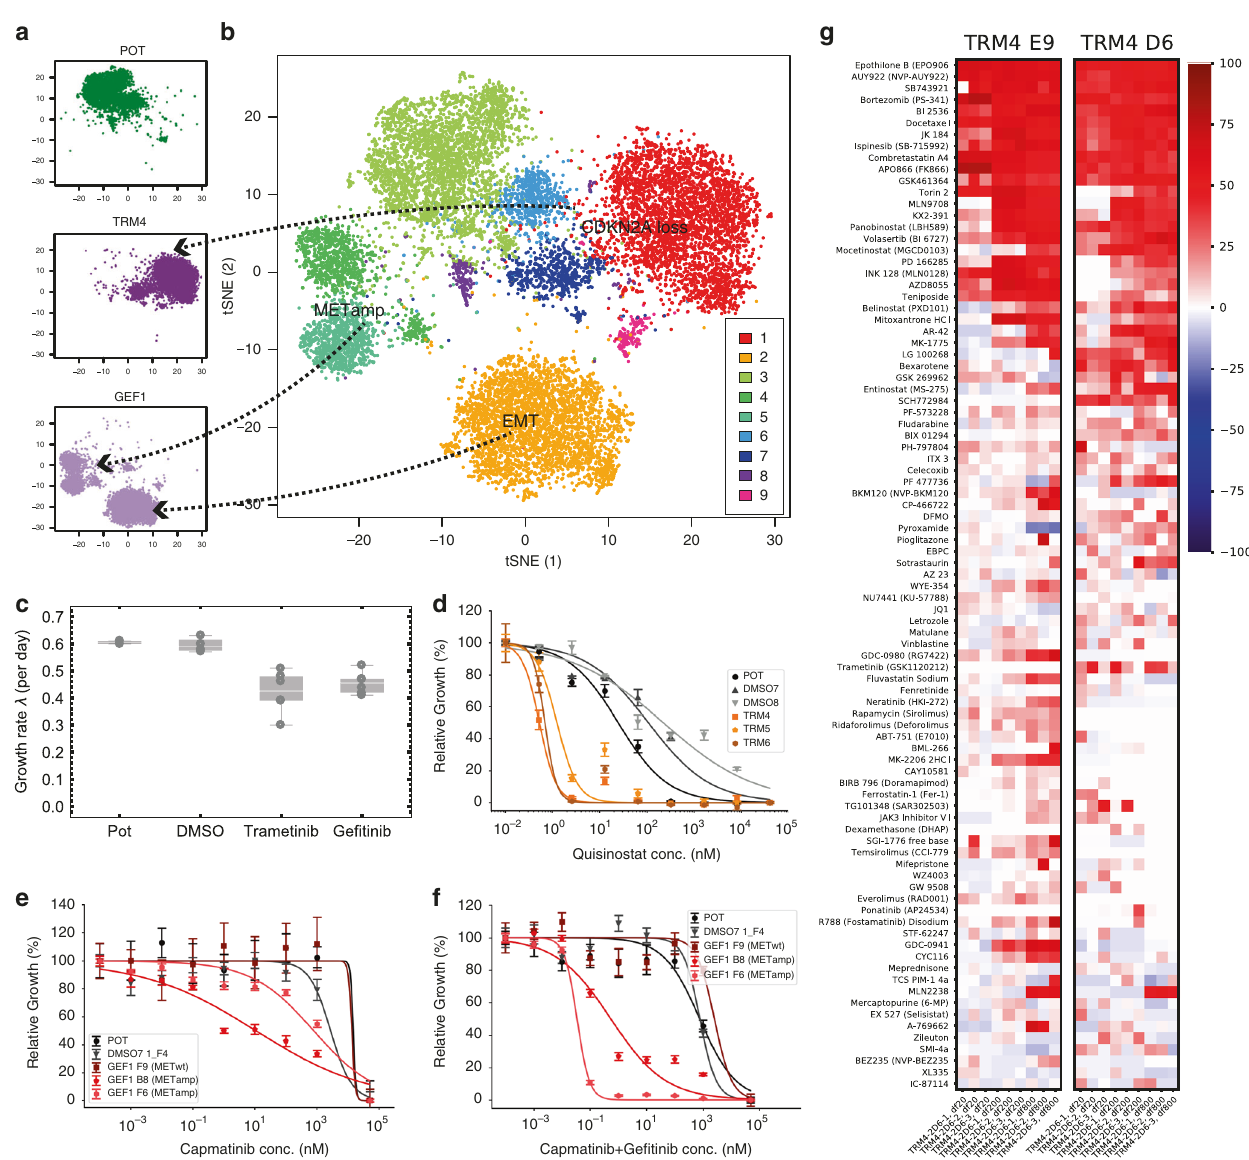
Fig. 5 Evolutionary steering leads to collateral drug sensitivity. a tSNE plot of single cell RNA sequencing coloured by sample (POT, TRM4 and GEF1 from top). b tSNE analysis of all samples together identi fi es 9 clusters with distinct transcriptomic pro fi les. c Growth rates of all lines in the absence of drugs show a cost of resistance in terms of proliferation in the evolve lines. Box plots show mean, interquartile values and the range. d Dose response curves of second generation HDAC inhibitor quisinostat show collateral drug sensitivity in TRM lines. e Dose response curve of single clones derived from ge fi tinib- resistant lines under MET inhibitor capmatinib show collateral sensitivity for clones that bear MET ampli fi cation (only B8 and F6). f Combination of capmatinib + ge fi tinib further increases collateral sensitivity of MET -ampli fi ed clones, in particular F6. g High throughput drug screening of 485 compounds shows collateral sensitivity in TRM clones TRM4 E9 (1 copy left of CDKN2A ) and TRM4 D6 (two copies left of CDKN2A ). Here we show top 5% with highest % change inhibition with respect to DMSO7 F4 (three copies of CDKN2A as HCC827 is a triploid line). Error bars of dose – response curves represent (Fig. 5a). Gene expression patterns con fi rmed that the ge fi tinib- population was mostly composed of a single CDKN2A loss sub- resistant population (GEF1) was composed largely of two major clone (Fig. 5b, cluster 1) and again CDKN2A loss was detectable subclones, one that was MET ampli fi ed (Fig. 5b, clusters 4 and 5) in a subpopulation of cells from the POT (cluster 6 — see Sup- and one that was EPCAM − /VIM + , indicative of epithelial to plementary Figs. 12 and 13). Hence, the scRNA-seq data con fi rms mesenchymal transition 45 or EMT (cluster 2). Indeed, EMT has the clonal composition reported by the barcodes. No over- been implicated in ge fi tinib resistance in lung cancer 35 . In expression of P-glycoprotein (PGP), a known multidrug resis- agreement with the pre-existing nature of these subclones, over- tance gene, was detected (Supplementary Fig. 13), supporting the expression of MET was detected in a subset of cells in the POT idea that drug-resistant clones have heritable phenotypes. Phos- (cluster 3 — see Supplementary Figs. 12 and 13). An EPCAM − / phoproteomic results validated our fi ndings in terms of the VIM + subpopulation was also present in the POT (cluster 9 — see functional effects of the drugs on the signalling pathways (Sup- Supplementary Figs. 12 and 13). The trametinib-resistant plementary Fig. 14, see “ Methods ” section).